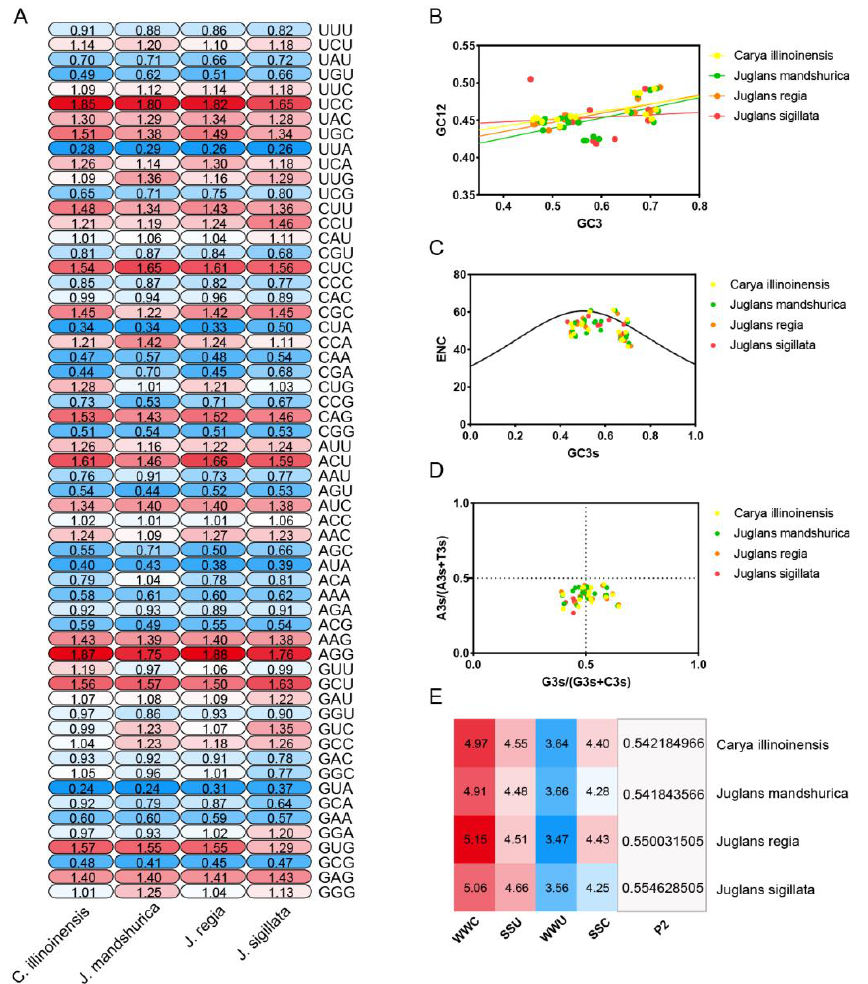
Figure 6. Codon bias ( A ), ENC-plot ( B ), Neutrality-plot ( C ), PR2-plot ( D ), and P2 analysis ( E ) in four Juglandaceae GRF gene families. four Juglandaceae GRF gene